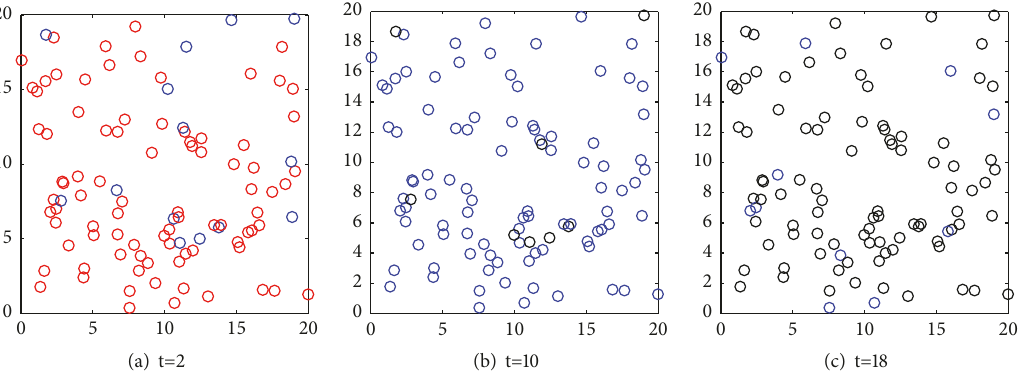
Figure 4: The users state in different time points at t=2, 10, 18.